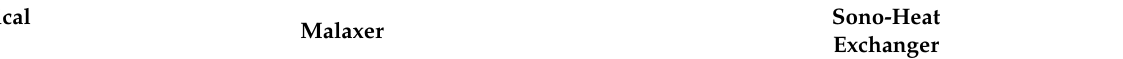
Table 1. The strengths of the new Sono-Heat-Exchanger compared to the obsolete